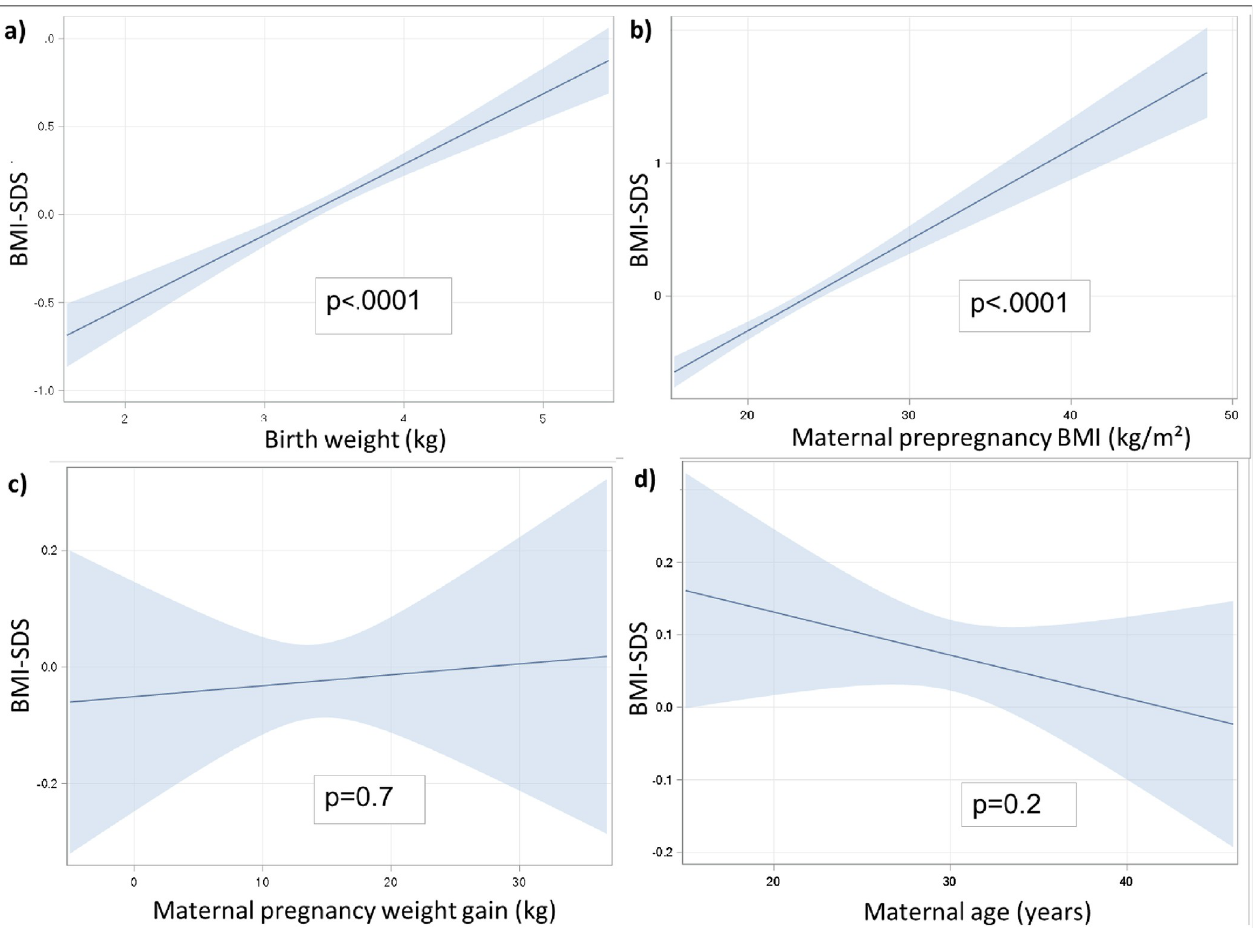
Fig 4. Effect plots of risk factors on BMI-SDS. Predicted values of BMI standard deviation score plotted against one continuous covariate/risk factor: a) birth weight; b) maternal prepregnancy BMI; c) maternal pregnancy weight gain; and d) maternal age. The calculations were made with mixed models, with the results stored in a special SAS item store; based on this calculation, the effect plots were generated in a statistical post-fitting analysis. 95% confidence intervals are shown as blue shade. Significance levels are shown in the plot for each respective risk factor. Significance was reached when: ��� p <